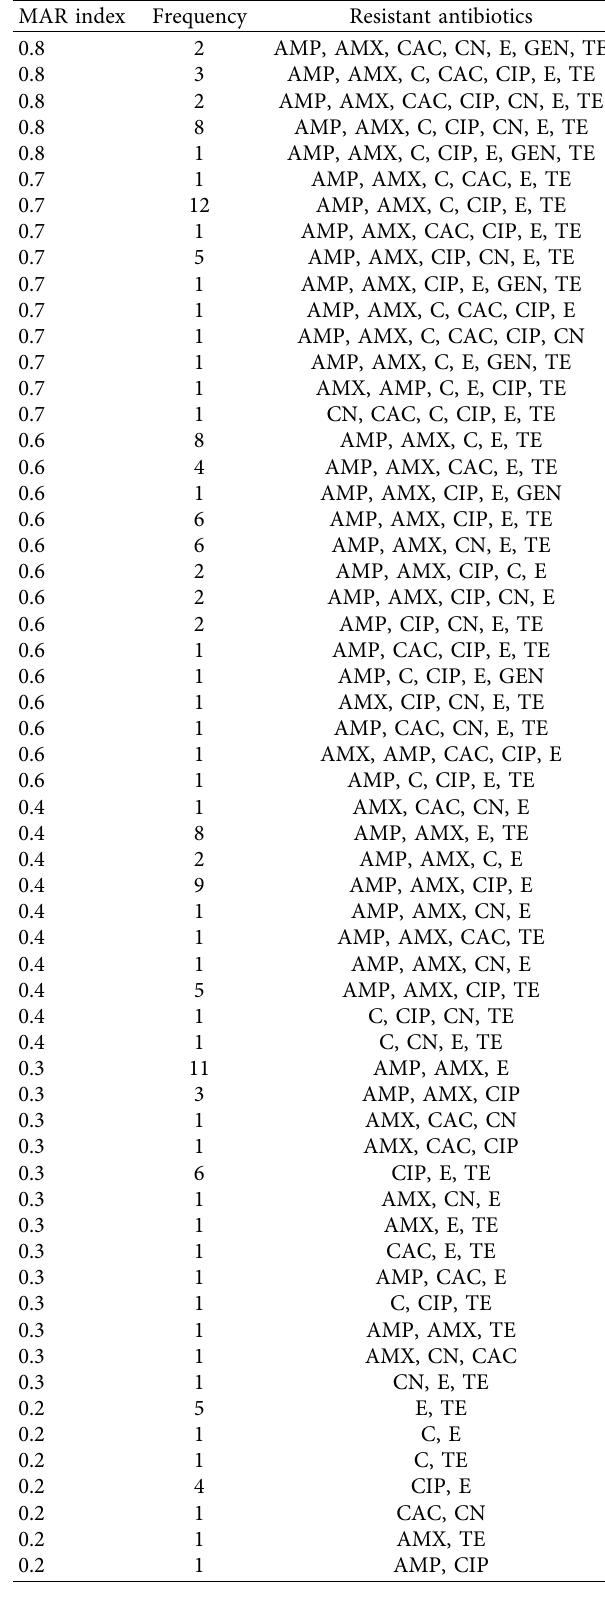
Table 3: MAR indexes and resistant antibiotics by antimicrobial resistance profiles of collected E. coli